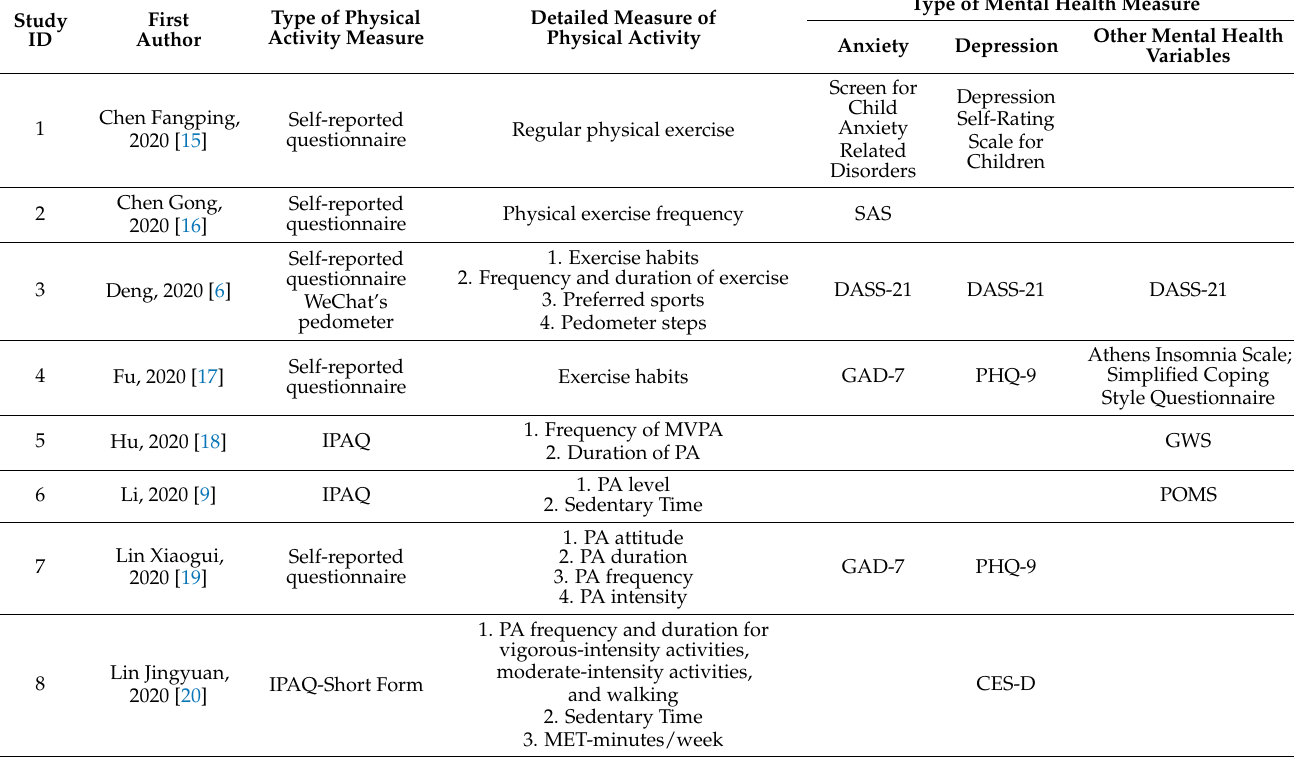
Table 2. Measures of physical activity and mental health in the studies included in the